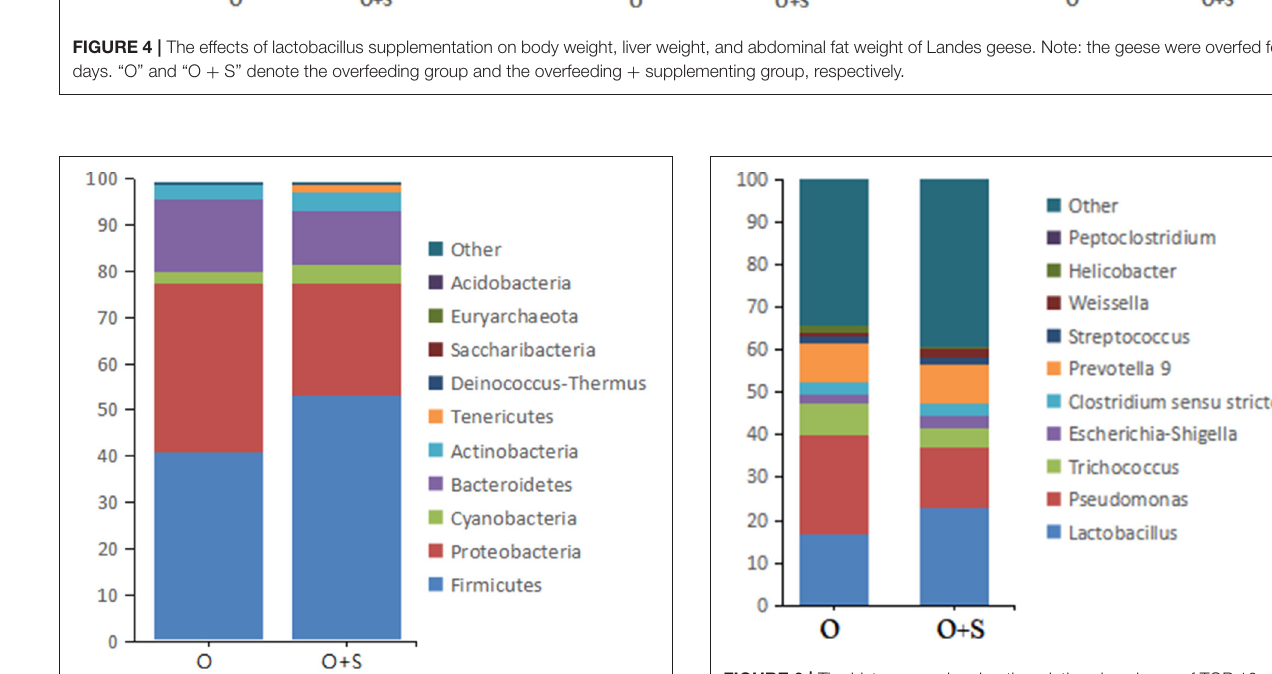
FIGURE 6 | The histograms showing the relative abundance of TOP 10 genera in the cecum of the overfeeding group and the supplementing group of geese (n = 15). Note: the relative abundance was acquired from 16S rRNA analysis. “O” and “O+S” denote the overfeeding group and the overfeeding + supplementing group,